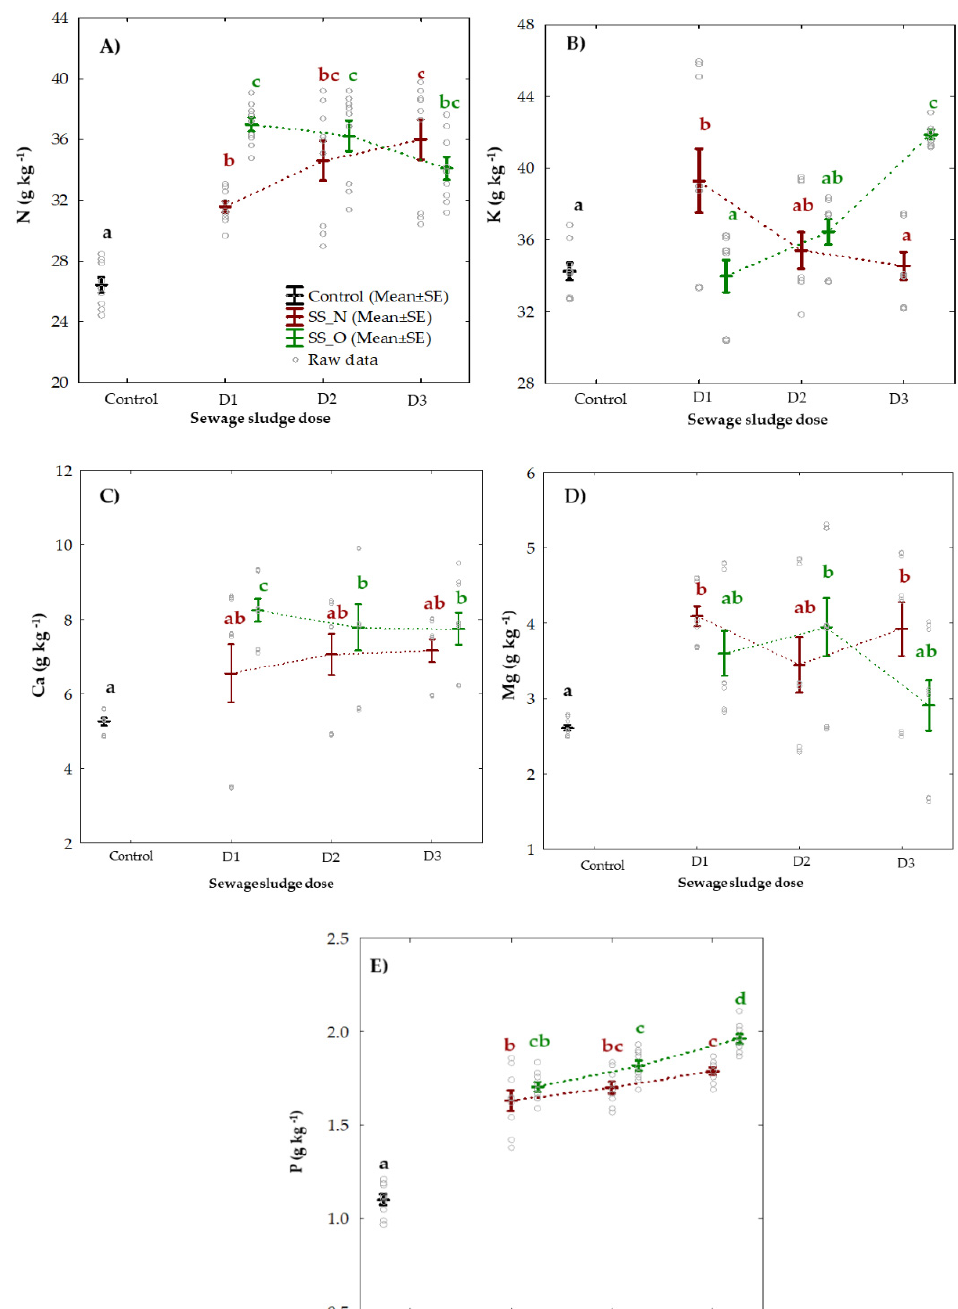
Figure 3. ( A – E ). Content of macronutrients (N, K, Ca, Mg, P) in the aboveground biomass of maize depending on the type and dose of sewage sludge (mean ± SE values from experiment series). Mean values ( n = 9) ± standard error. Identical superscripts denote no significant ( p > 0.05) differences between the experimental variants according to the post hoc Tukey HSD test. Explanation: SS_N—non-ozonated sewage sludge; SS_O—ozonated sewage sludge; D1, D2, D3—dose of sewage sludge—3, 6, 9 Mg ha − 1 ,